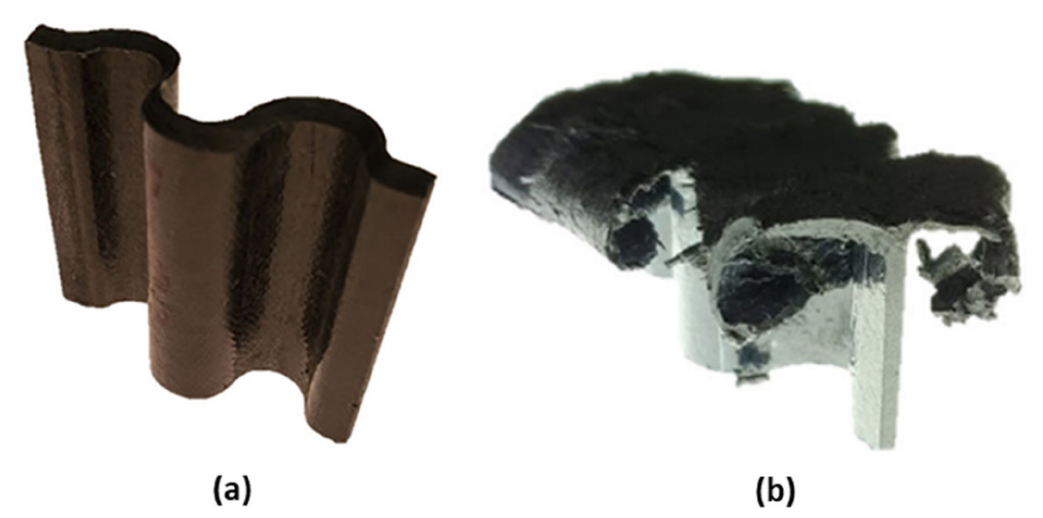
Figure 15. Constant cross-section crush specimens in the sinusoidal geometry: ( a ) untested sample and ( b ) failed sample. Reprinted with permission from [88]. Copyright 2021